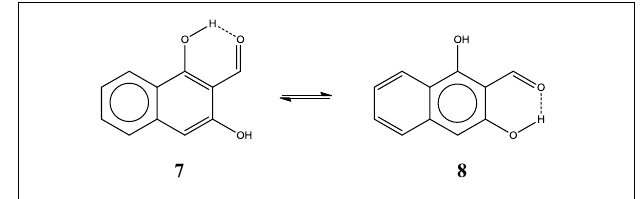
Scheme 9 | Clar structures for species III (A and B) and IV (C and D) of Scheme